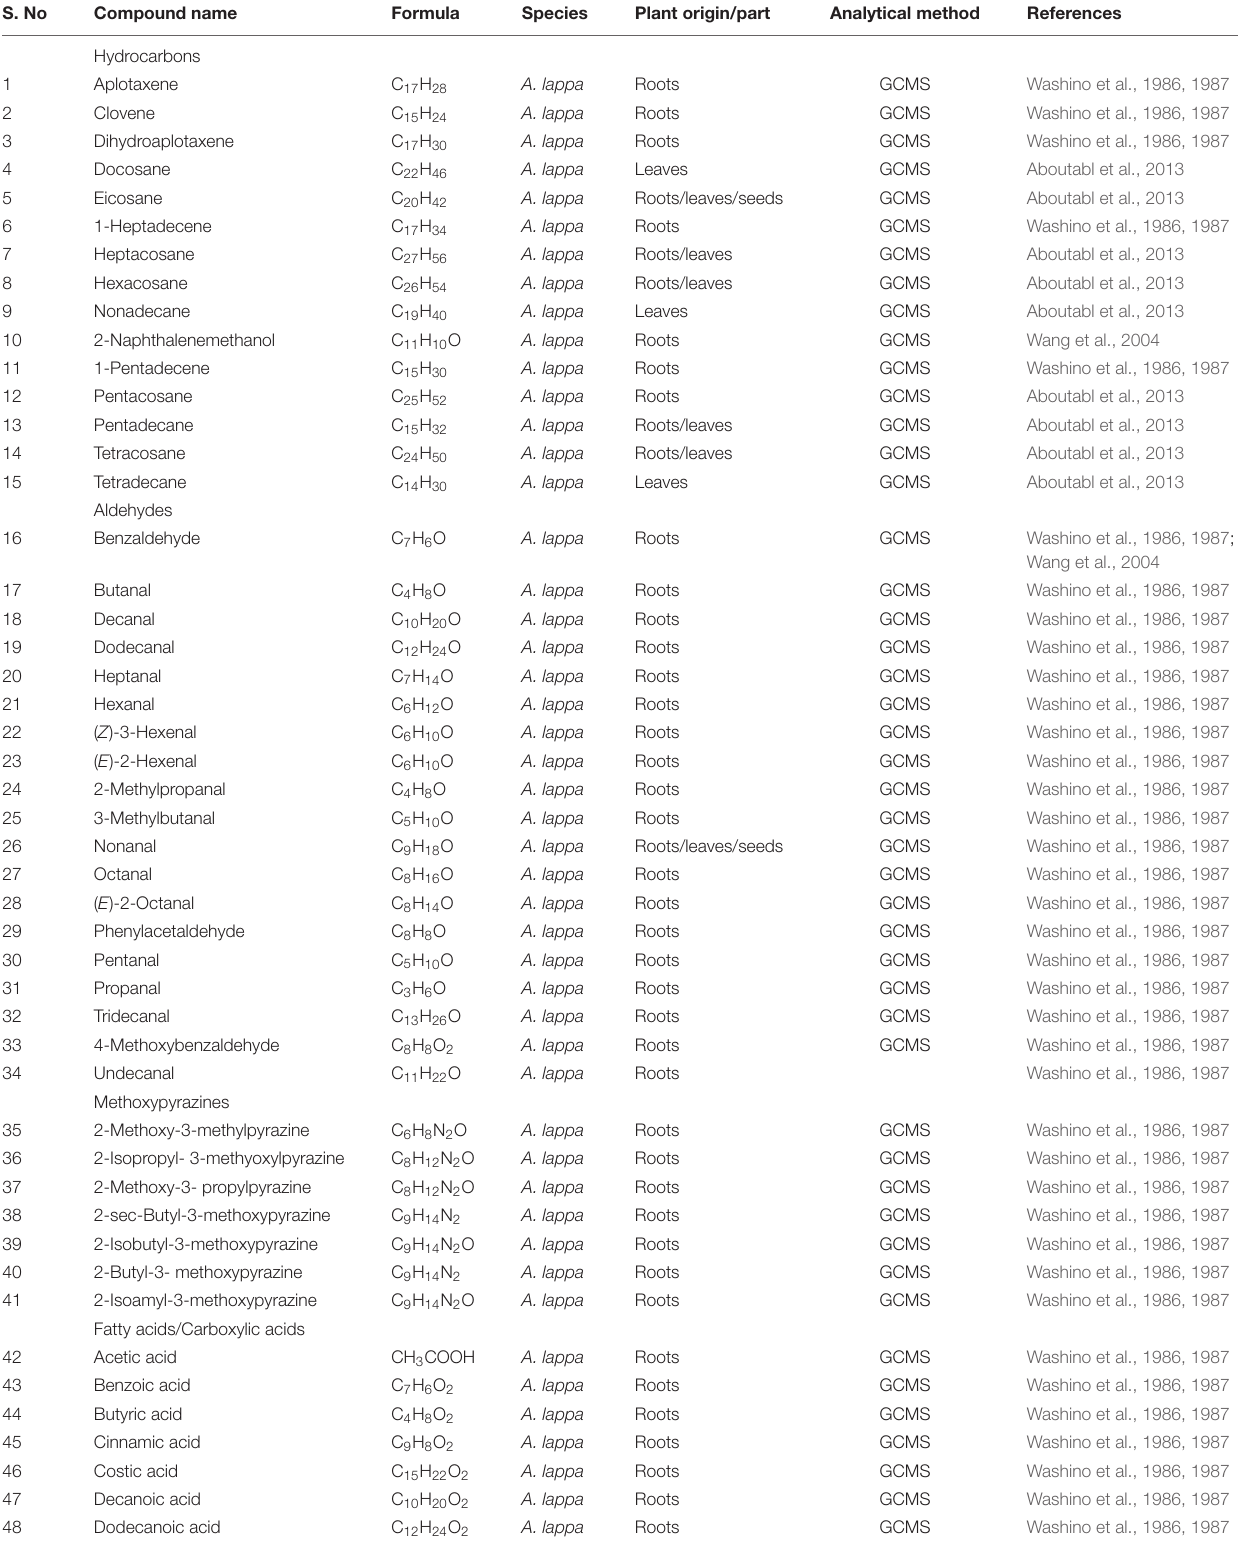
TABLE 2 | Volatile constituents of Arctium